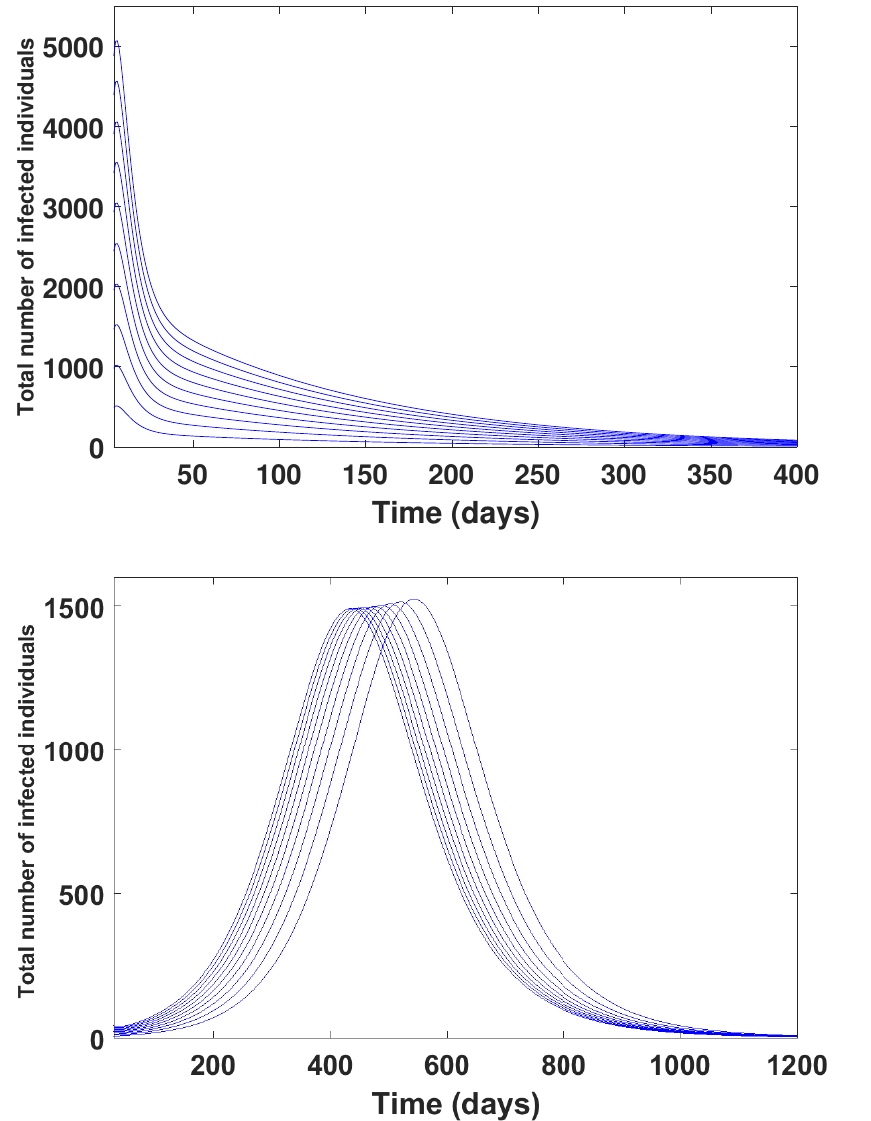
Figure 3. The infected compartments as functions of time when R 0 = 0.7468 < 1 ( Up ). The infected compartments as functions of time when R 0 = 1.4936 > 1 ( Down